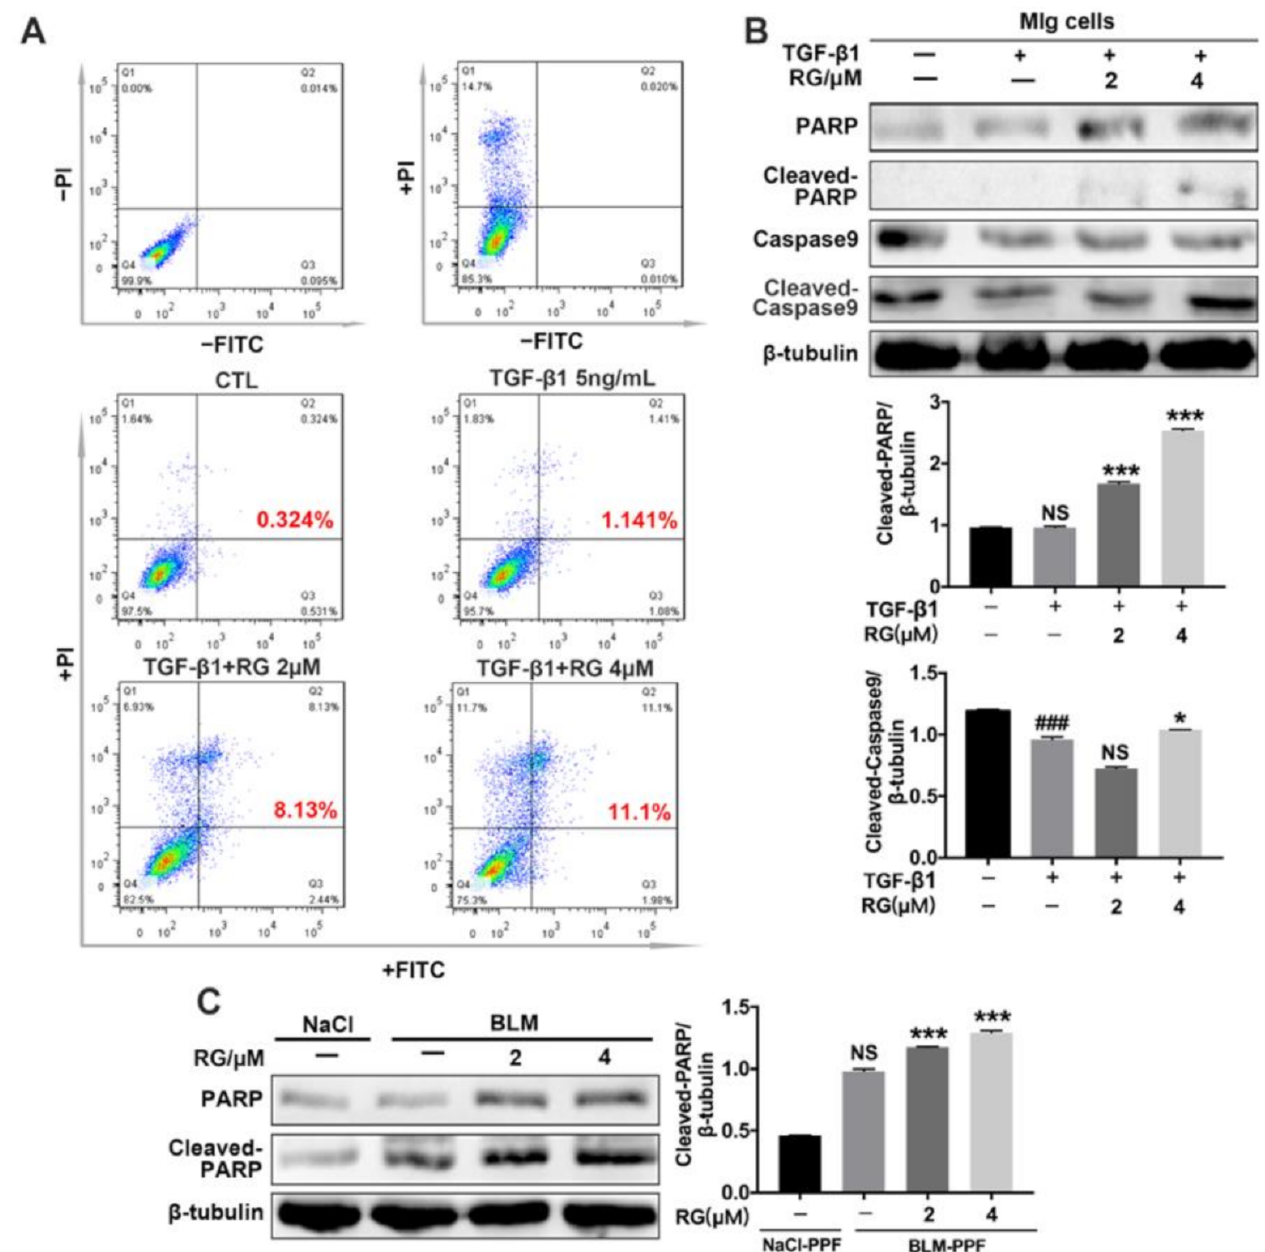
Figure 5. Regorafenib promotes TGF- β 1-induced apoptosis of myofibroblasts. ( A ) Mlg cells were treated with TGF- β 1 and/or RG (2 µ M, 4 µ M) for 24 h. Annexin V/PI staining was subsequently performed to assess early-apoptosis cells, late-apoptosis cells, and necrosis cells; 5 × 10 3 cells were analyzed by flow cytometry; ( B ) Mlg cells were treated with TGF- β 1 and/or RG (2 µ M, 4 µ M) for 24 h, and expression levels of Caspsed9 and PARP and their activation were detected by Western blotting. Densitometric analysis are shown below; ( C ) RG (2 µ M, 4 µ M) was exposed to BLM-PPF cells for 24 h, and the expression levels of PARP and its activation were detected by Western blot. Densitometric analyses are shown. Data in ( B , C ) are means ± standard error of mean (SEM), ### p < 0.001, * p < 0.05, *** p < 0.001 (one-way ANOVA), NS: not